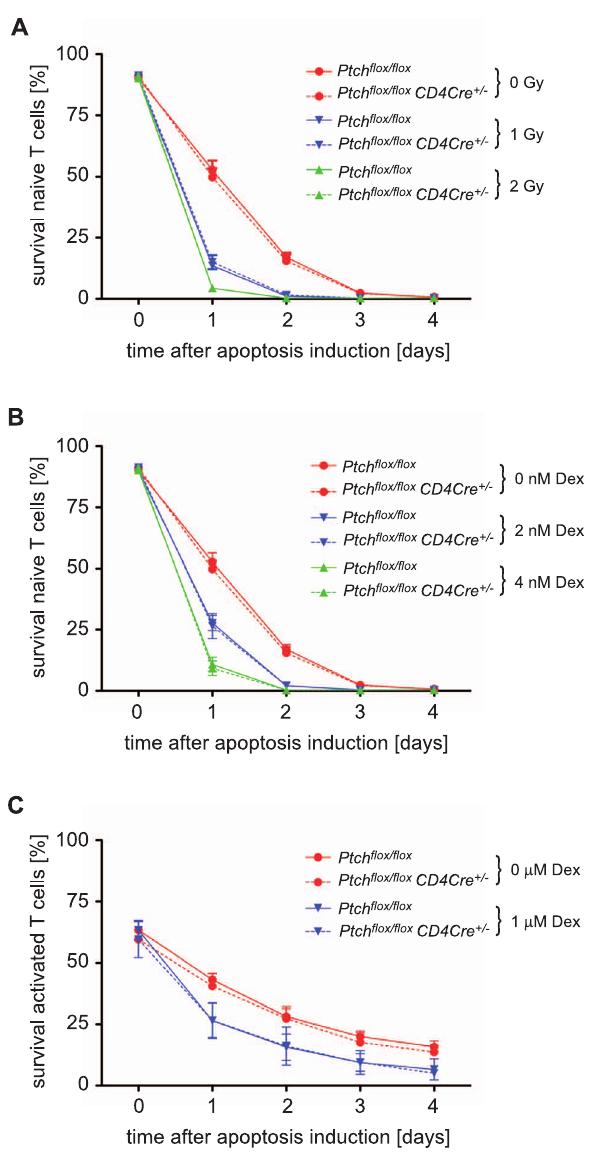
Figure 5. Sensitivity of T cells to apoptosis induction. (A) Apoptosis induction by c -irradiation was assessed by culturing 2 x 10 5 T cells following exposure to a dose of 1 or 2 Gy or without any manipulation. Cell viability was assessed every 24 hours by FACS analysis using 7-AAD. Results represent the mean 6 SEM of three independent experiments. (B) Glucocorticoid-induced apoptosis was investigated by culturing 2 x 10 5 splenic T cells from Ptch flox/flox control or Ptch flox/flox CD4Cre + / 2 mutant mice in medium with or without 2 or